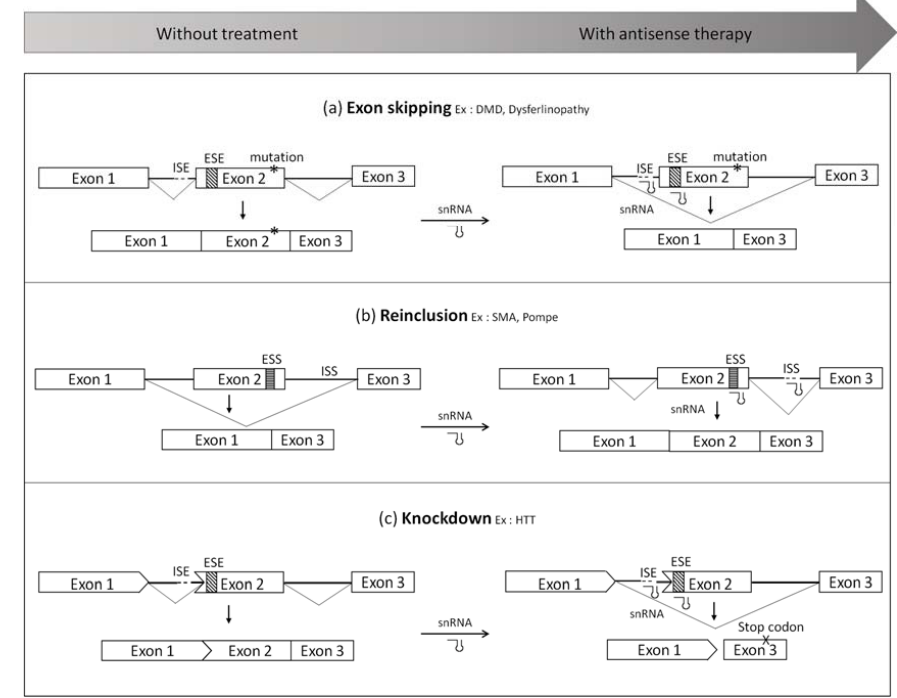
Figure 2. Splicing modulation mediated by small nuclear RNAs (snRNA) system ( a ) Exon ‐ skipping. This approach consists in using modified snRNA to hide important splice sites